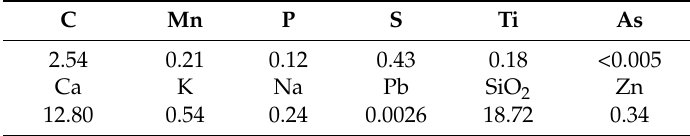
Table 3. Harmful element composition of the adherent slag (wt. %).